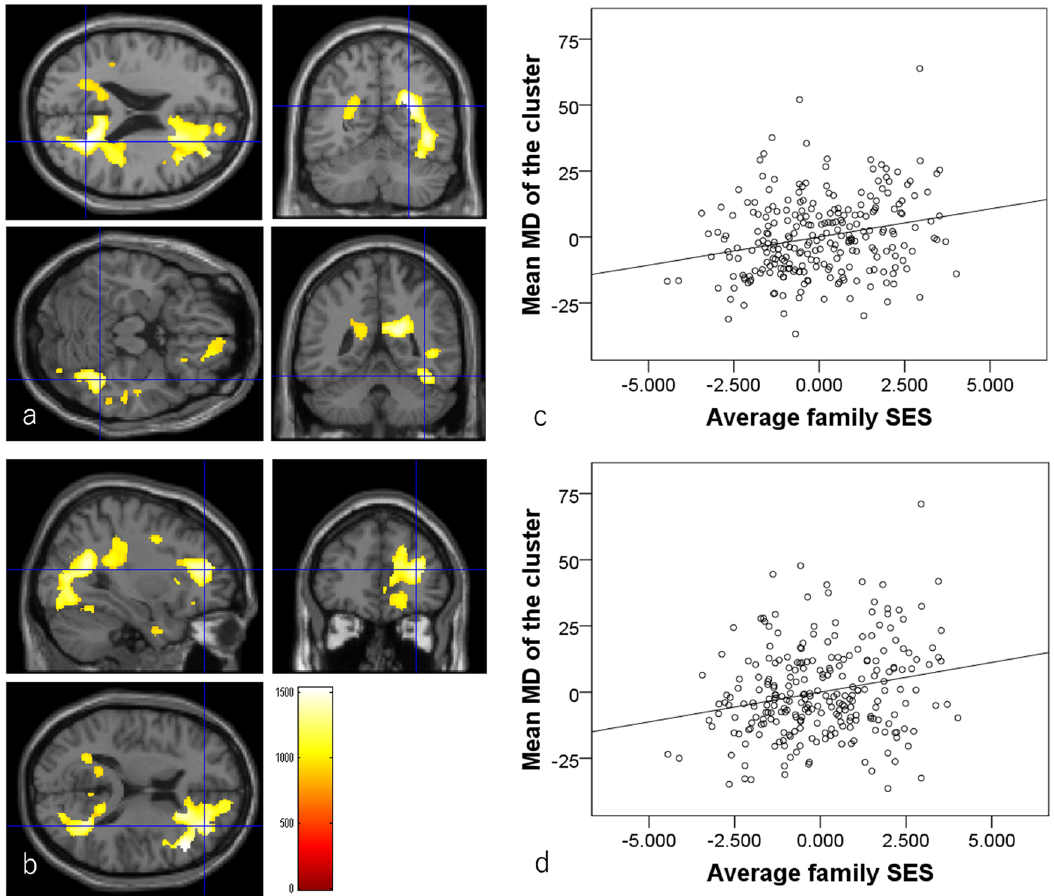
Fig. 4 Associations between higher childhood SES and MD in cross-sectional analyses ( N = 253). The results shown were obtained using a TFCE of P < 0.05 based on 5000 permutations. The results were corrected at the whole-brain level. Signi fi cantly associated regions were overlaid on a “ single subject ” T1 image. The color represents the strength of the TFCE value. Positive associations between MD and childhood SES. Signi fi cant associations were observed in the anatomical cluster that primarily spread across the right fusiform gyrus and surrounding areas ( a ) and in the anatomical cluster among the prefrontal cortex, striatum, anterior cingulate gray and white matter areas, and related regions ( b ). c , d Partial residual plots with trend lines depicting associations between residuals in the multiple regression analyses. The mean MD from the signi fi cant clusters shown in ( a ) and ( b ) respectively were used as the dependent variables and childhood SES was the independent